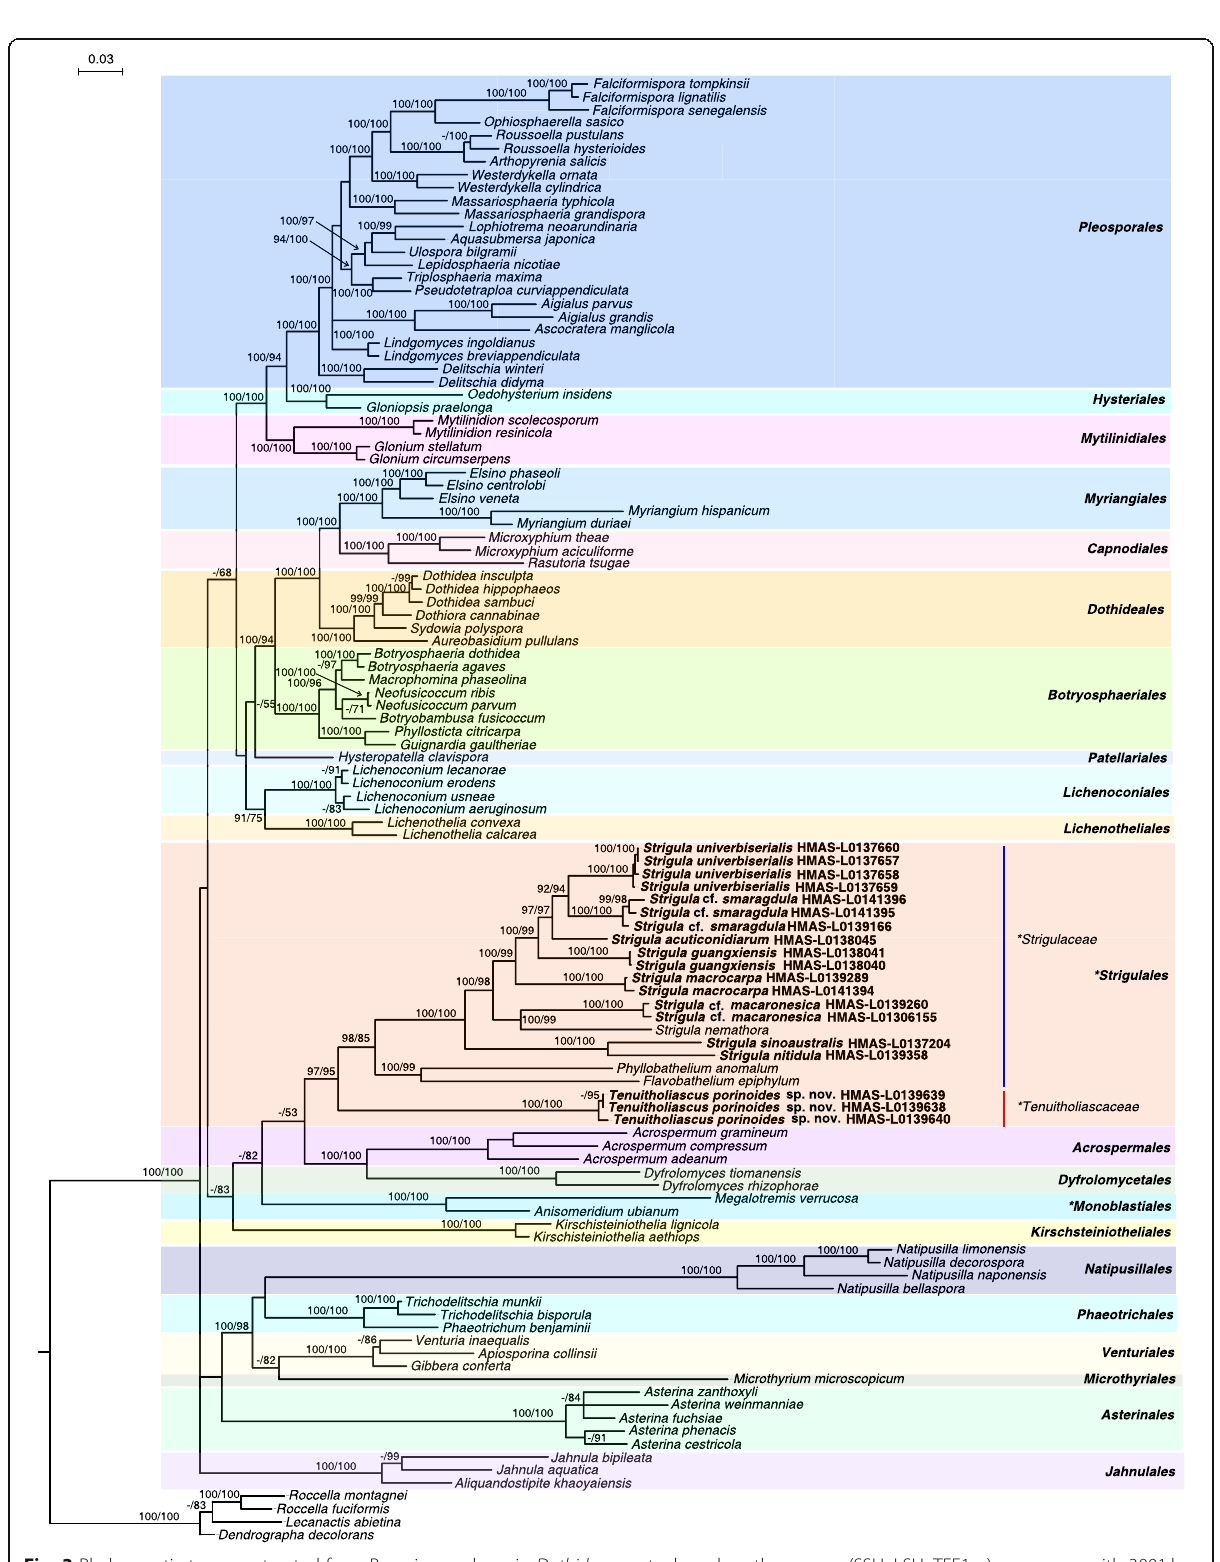
Fig. 3 Phylogenetic tree constructed from Bayesian analyses in Dothideomycetes based on three gene (SSU, LSU, TEF1- α ) sequences with 3001 bp. Bayesian inference posterior probabilities above 90% (left) and Maximum likelihood bootstrap probabilities above 50% (right) are shown at nodes (B – PP / ML – BP). The families and orders including lichenized taxa are marked with *. The tree was rooted to Arthoniomycetes